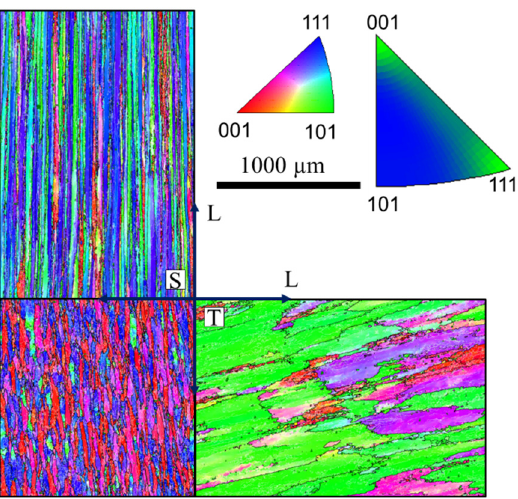
Figure 3. EBSD map showing the grain structure with high angle grain boundaries > 15° for the AA7010-T7452 var 4. The colors indicate the crystallographic direction normal to the material’s plane shown, i.e., The colors for the L-T-plane show the crystallographic direction parallel to